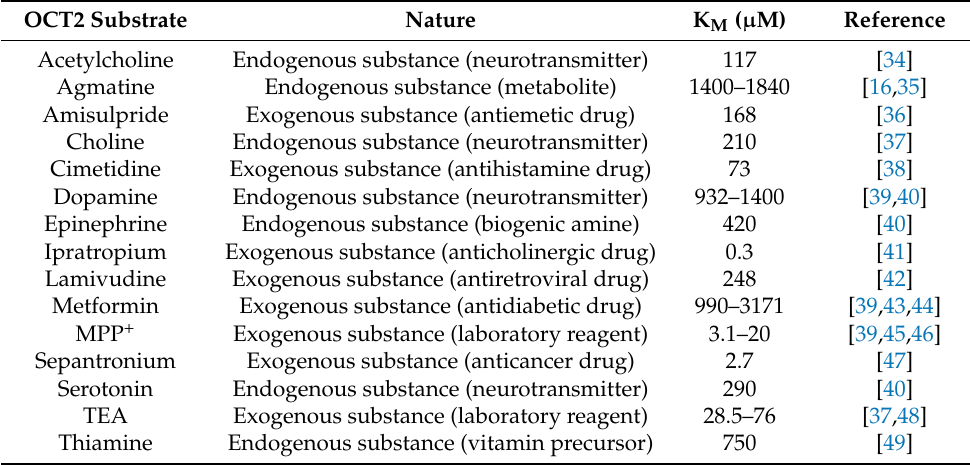
Table 1. Affinity for OCT2 (K M values) of substrates used in the study. OCT2